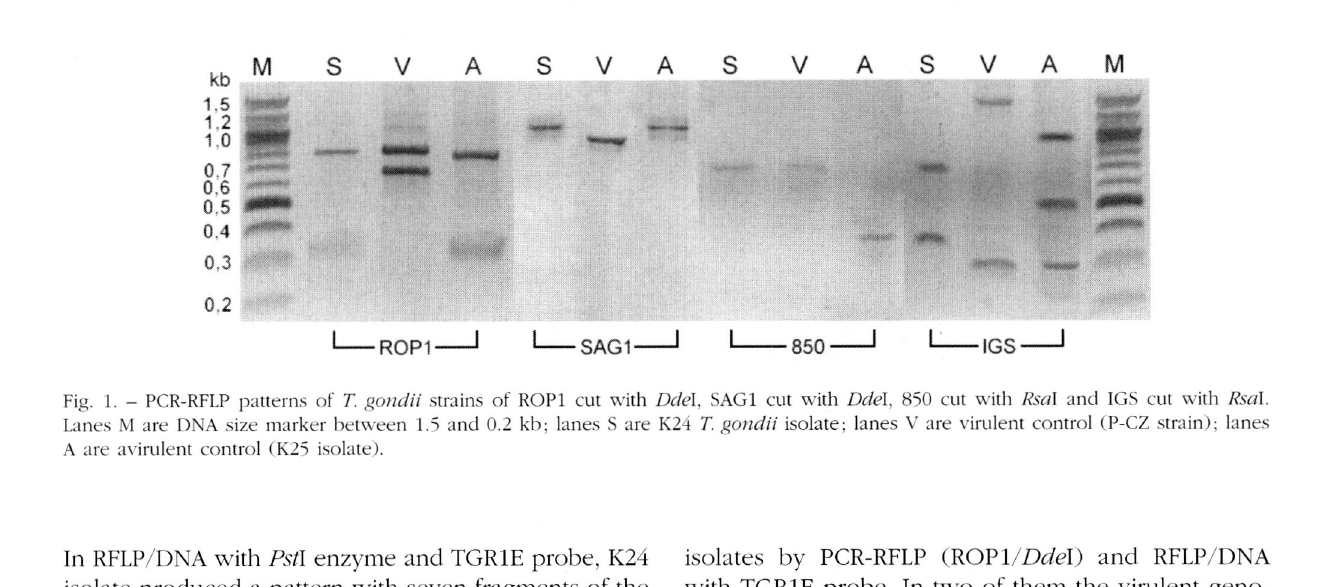
Fig. 1. - PCR-RFLP patterns of T. gondii strains of ROP1 cut with Ddel, SAG1 cut with Ddel, 850 cut with Rsal and IGS cut with Rsal. Lanes M are DNA size marker between 1 .5 and 0.2 kb; lanes S are K24 T. gondii isolate; lanes V are virulent control (P-CZ strain); lanes A are avirulent control (K25